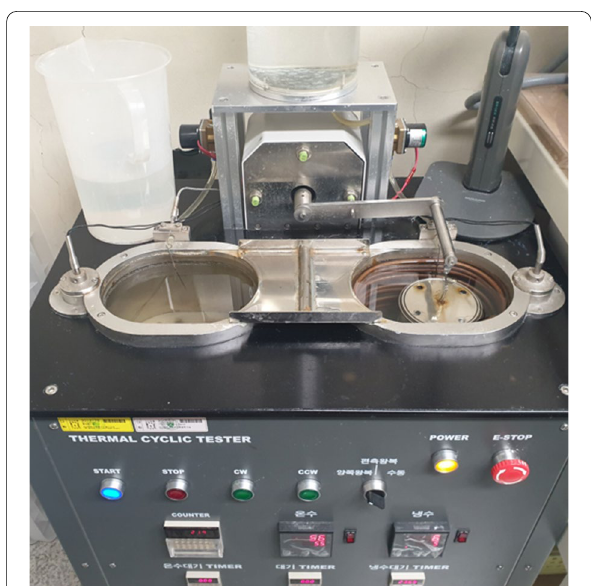
Fig. 6 Thermal cyclic tester (R&B Inc., Daejeon, Korea)